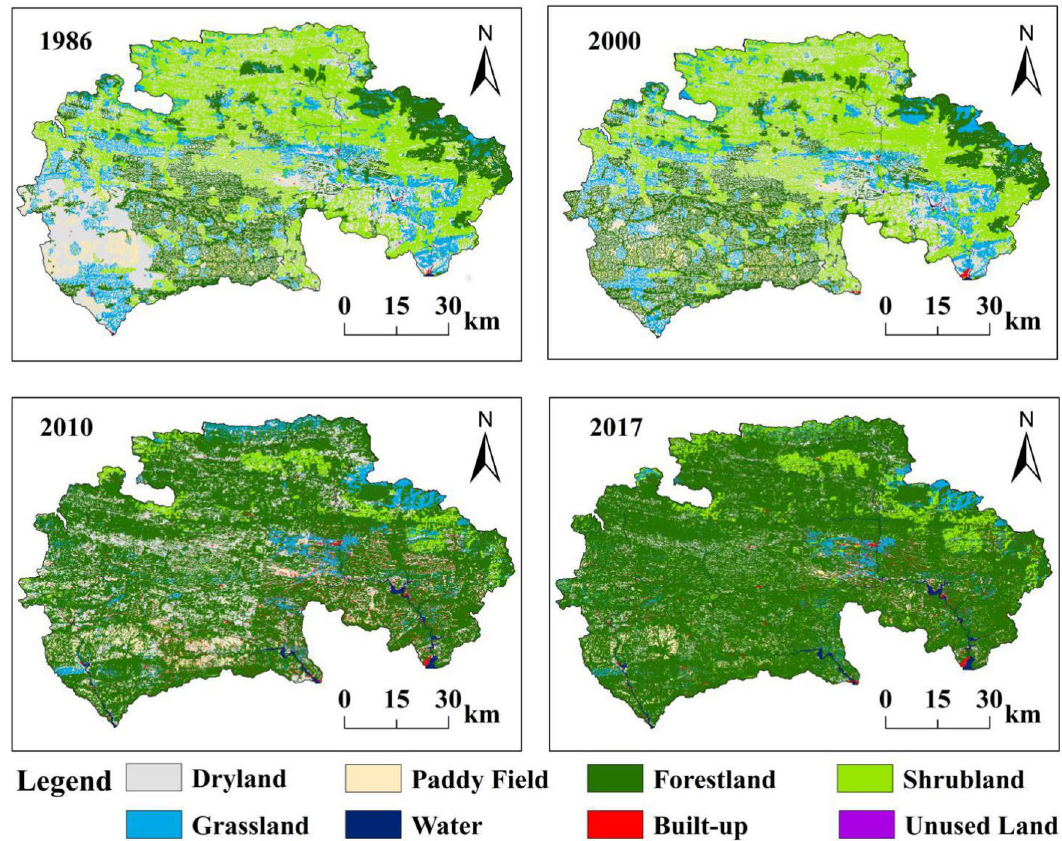
Figure 4. The spatial division of landscape type in the watershed from 1986 to 2017. Maps were generated using ArcGIS 10.2 for Desktop (http:// www. esri. com/ sofwa re/ valleys with slopes within 15°. From 2000 to 2010, the K -values for altitude and slope changed differently. Waters and built-up areas showed clear increasing trends at elevation gradients below 1000 m, while forestland and waters showed the most pronounced increases in each slope zone. This dramatic increase was mainly due to the rise in reservoir levels and the implementation of the national migration policy. As a result of urbanization, the total amount of built-up areas exhibited an upward trend from 2010 to 2017 in the middle mountainous areas where the elevations were higher than 1500 m. Figure 5b represents the trend of P in landscape type along with land classification at each time point. In the period 1986–2000, the landscaping trend changed slightly except in valley areas. In this region, forestland, water, and built-up areas all expanded in an “upward” fashion. From 2000 to 2010, land use trends varied for elevation and slope. Cultivated land increased for slopes less than 8°; in areas below 1000 m elevation and with slopes less than 15°, settlements were the dominant landscape, and in both low and steep slope areas, water sources increased greatly as the water level rose. From 2010 to 2017, the landscape trends changed slightly, except in the valley and mid-mountain areas. In the valley areas, shrublands expanded in an “ascending” fashion. For the mid-hills, the built-up area expanded remarkably in an “ascending” state. In general, landscape types in the watershed change at different rates and trends along elevation, slopes, and buffers, and the changes are phased and exhibit a process that changes from quantitative to qualitative. The period from 2000–2010 experienced the most intense landscape evolution during the impoundment period. Analysis of changes in the level of land use degree ( LA ) in the buffer zones. We used the Inter- sect tool in ArcGIS 10.2 software to overlay the landscape types of different landform maps with the water- shed buffers and then calculated the index of landscape type change intensity ( LA ) values based on the method described in Formula (3), and the results are shown in Figs. 6 and 7. Variations in buffer distance reflect some extent the variations in upstream and downstream distances. Fig- buffer zone, the terrain is relatively flat, dominated by micro-slopes, and influenced by the intensity of human activities, while the degree of development is relatively high. As illustrated in Fig. 7, the landscape changes in different land types in buffer zones of the watersheds varied from 1986 to 2017. Within the 30 km buffer, all land types in the TR had the highest landscape synthesis with reduced fluctuations around them, while the landscape synthesis in the MR and DR buffers showed notably